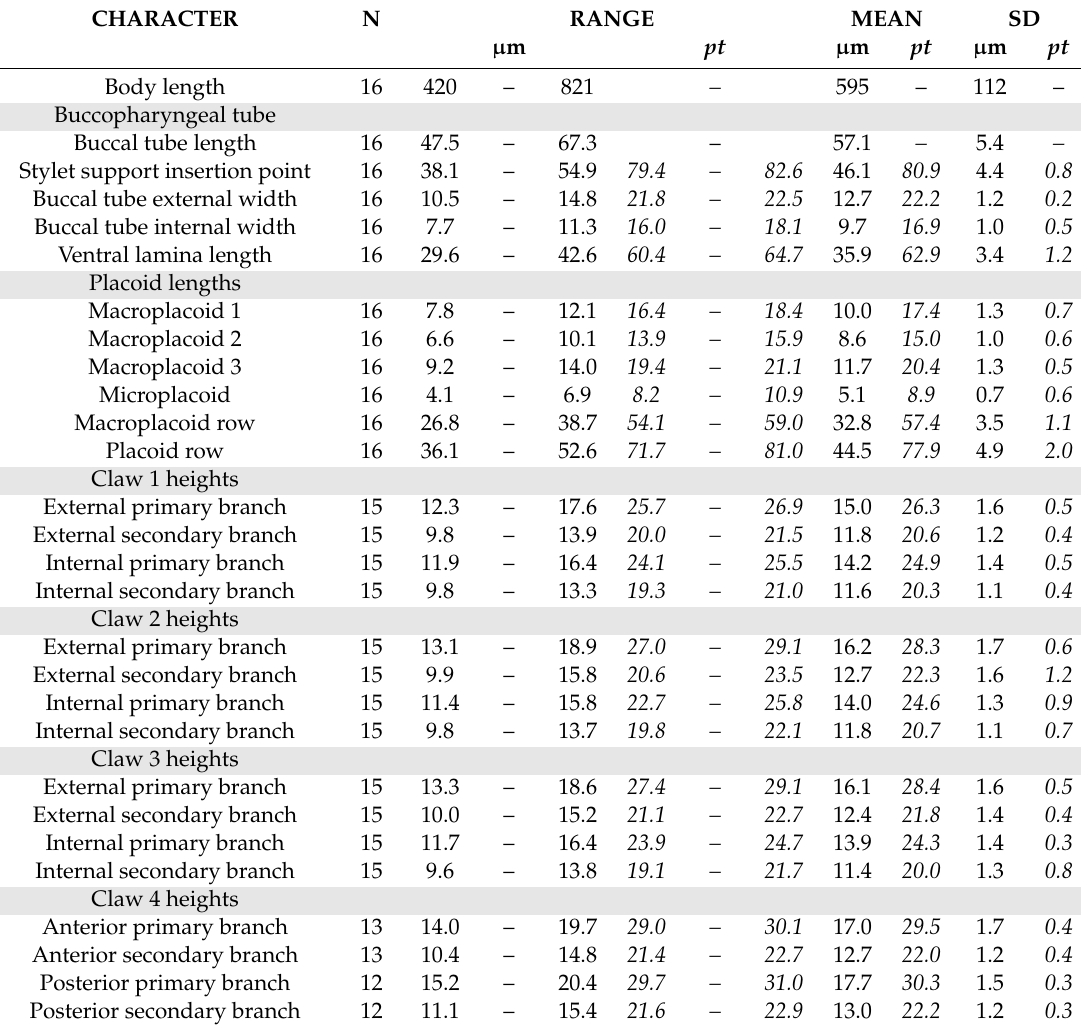
Table 3. Measurements (in µ m) and pt values of selected morphological structures of individuals of the Antarctic population of Paramacrobiotus fairbanksi Schill, Förster, Dandekar and Wolf [25] mounted in Hoyer’s medium (N, number of specimens / structures measured; RANGE refers to the smallest and the largest structure among all measured specimens; SD, standard deviation; pt , ratio of the length of a given structure to the length of the buccal tube expressed as a